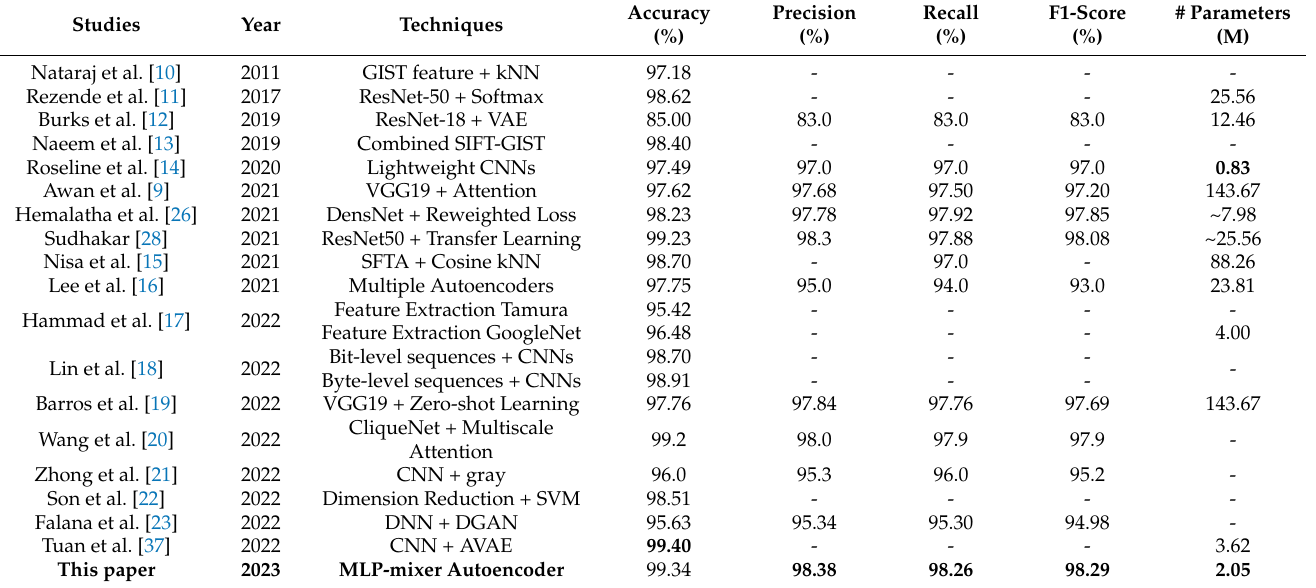
Table 6. Comparison with the latest malware classification models on the Malimg dataset.